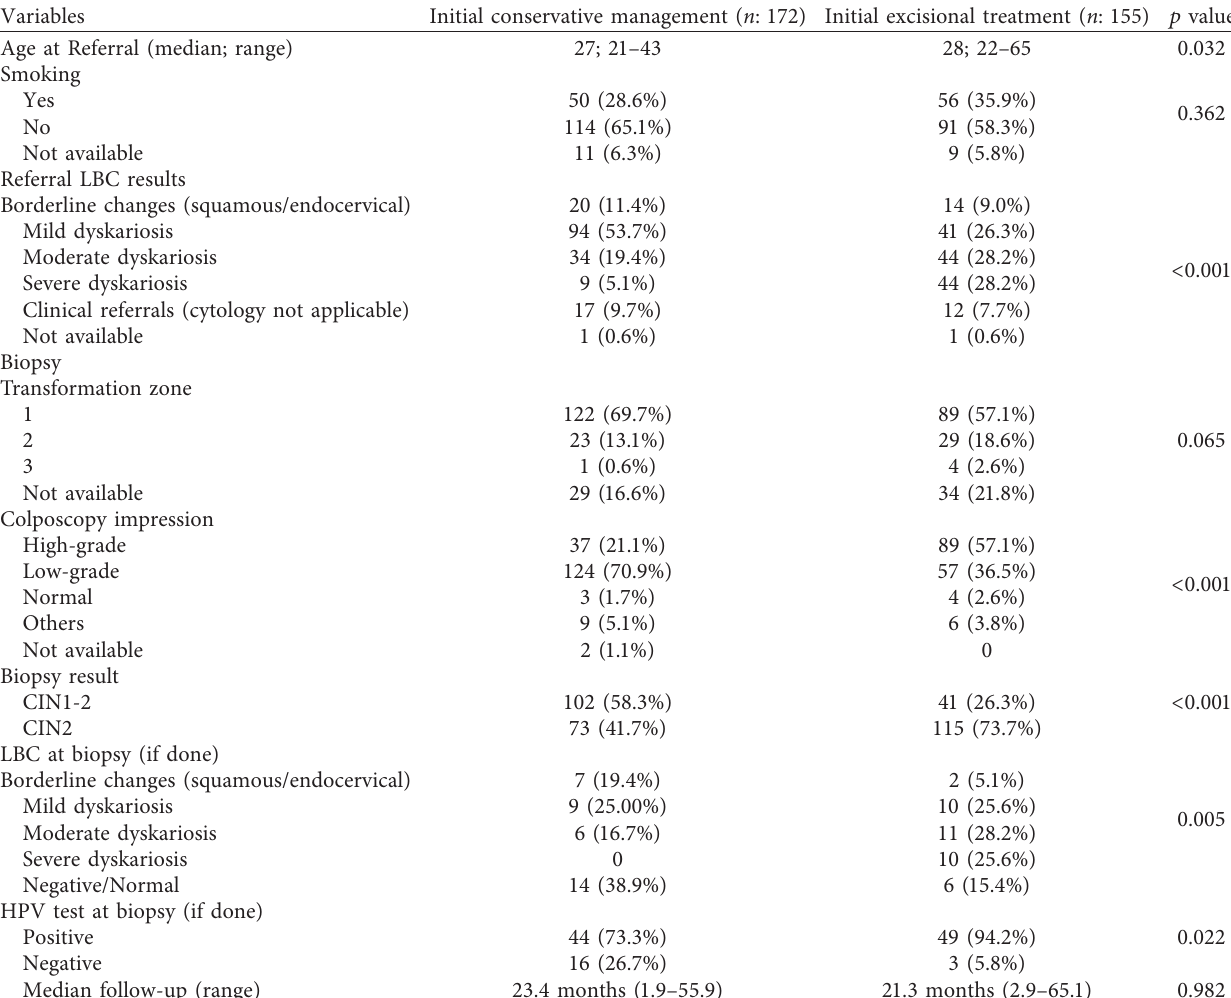
Table 1: Demographics, risk factors, and clinical results from colposcopy.